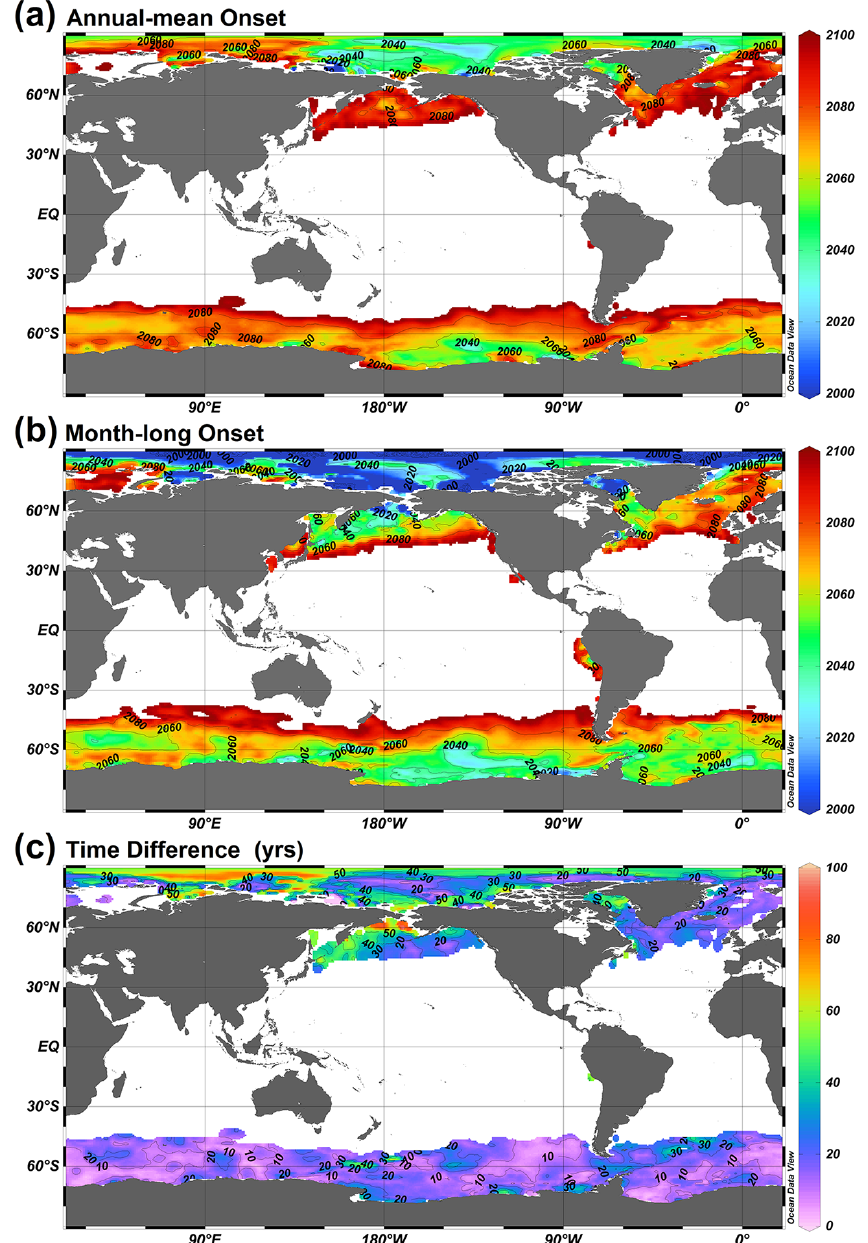
Figure 7. Estimated onset year for aragonite undersaturation under RCP8.5 for (a) annual-mean and (b) 1-month onset. (c) Time difference (years) between annual-mean and month-long